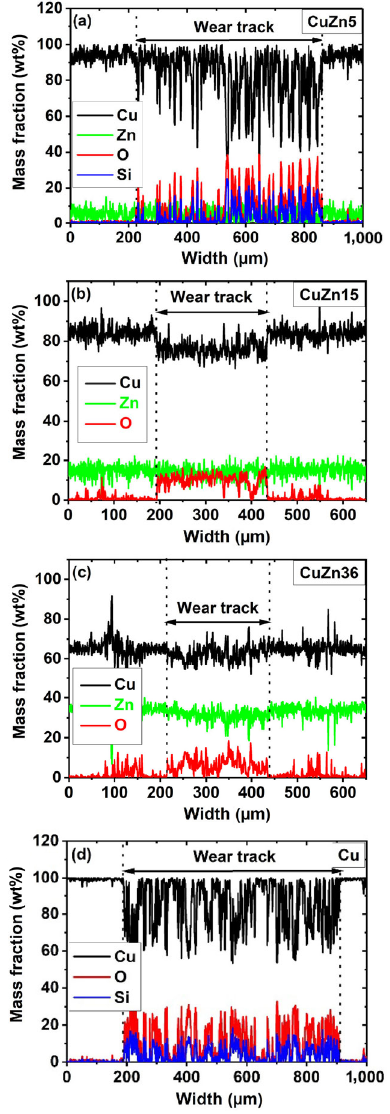
Fig. 4 Distribution of chemical elements across wear tracks after 5,000 sliding cycles for copper and  -brass samples with 5, 15, and 36 wt% of zinc. Line scans perpendicular to the wear tracks were performed with a FIB/SEM DualBeam system using an EDS detector (accelerating voltage of 10 keV, beam current of 0.8 nA). widths of the wear tracks are marked by vertical dashed lines and double arrows.